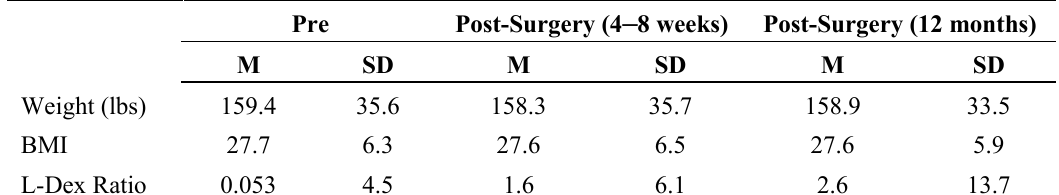
Table 3. Weight, BMI, and L-Dex ratios during